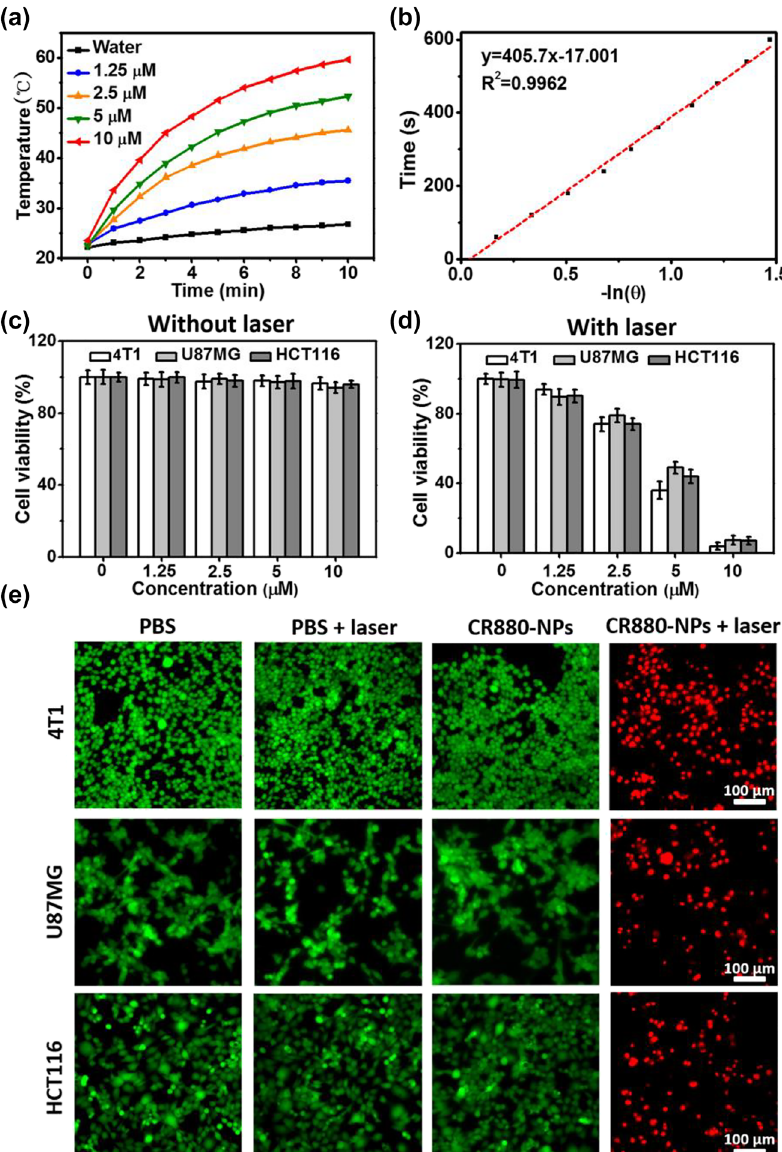
Figure 4: Photothermal effect of